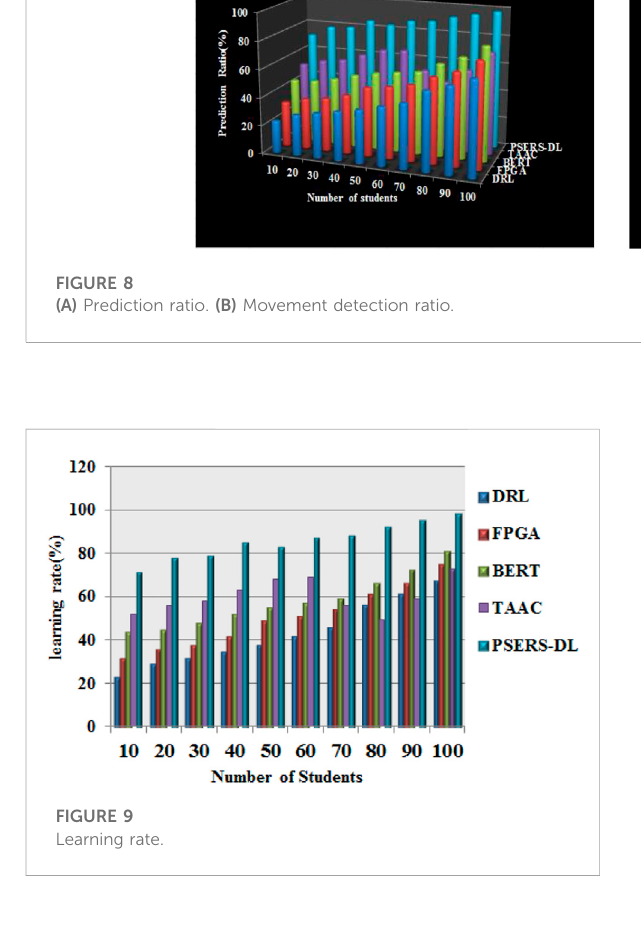
FIGURE 10 Accuracy